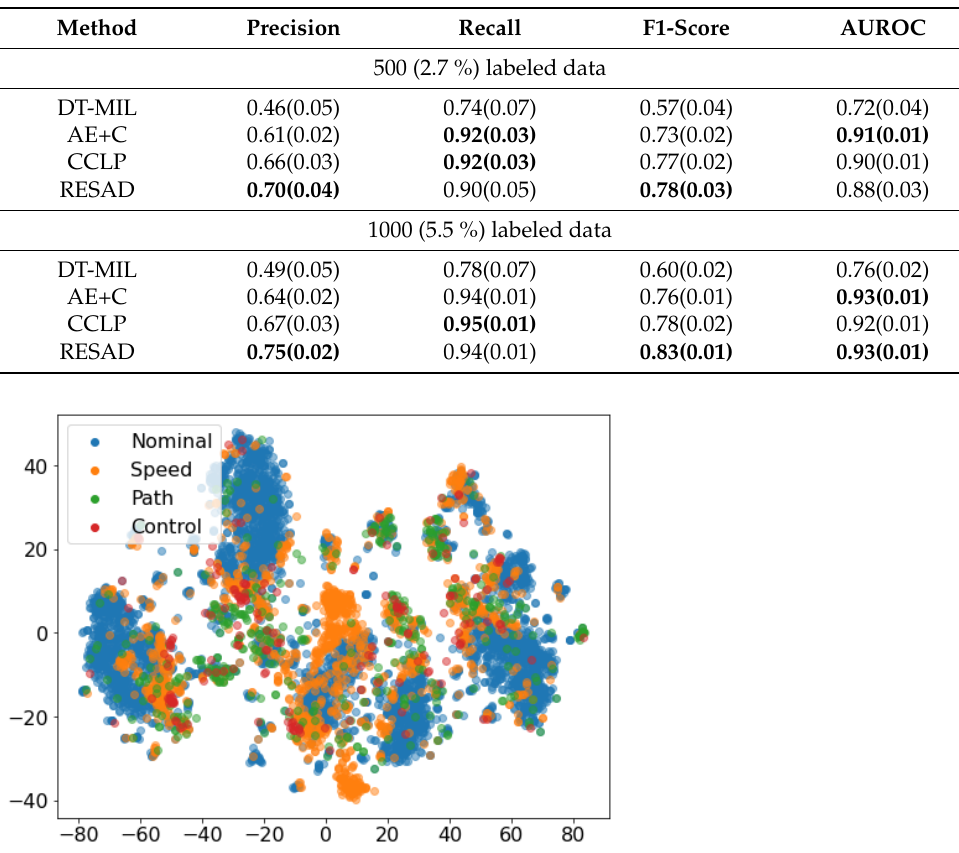
Figure A4. This figure shows the 2D visualization of the flight time-series using t-SNE, color-coded based on the true class to which each data belongs.